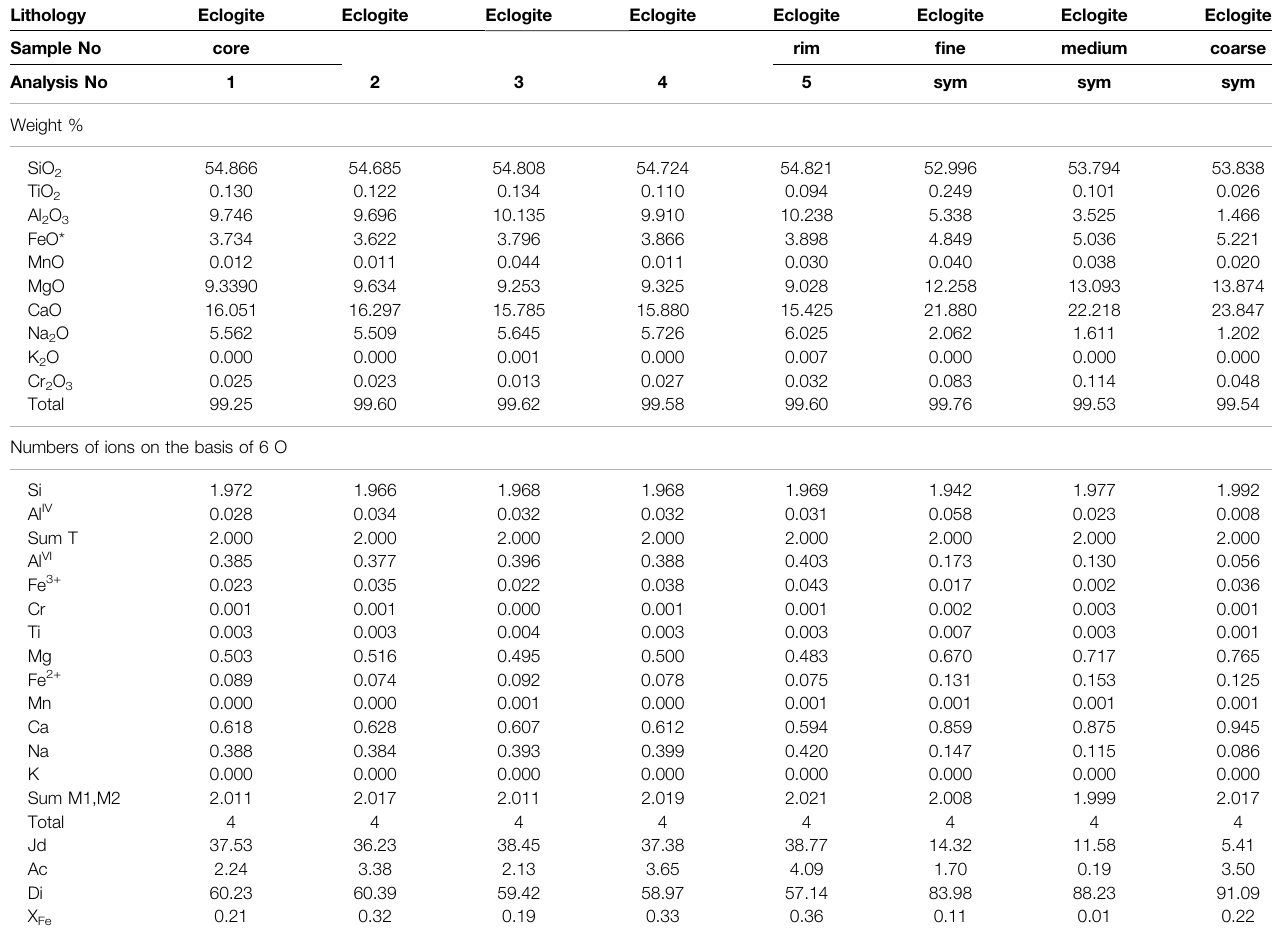
TABLE 2 | Representative EPMA analyses of omphacite and symplectite in